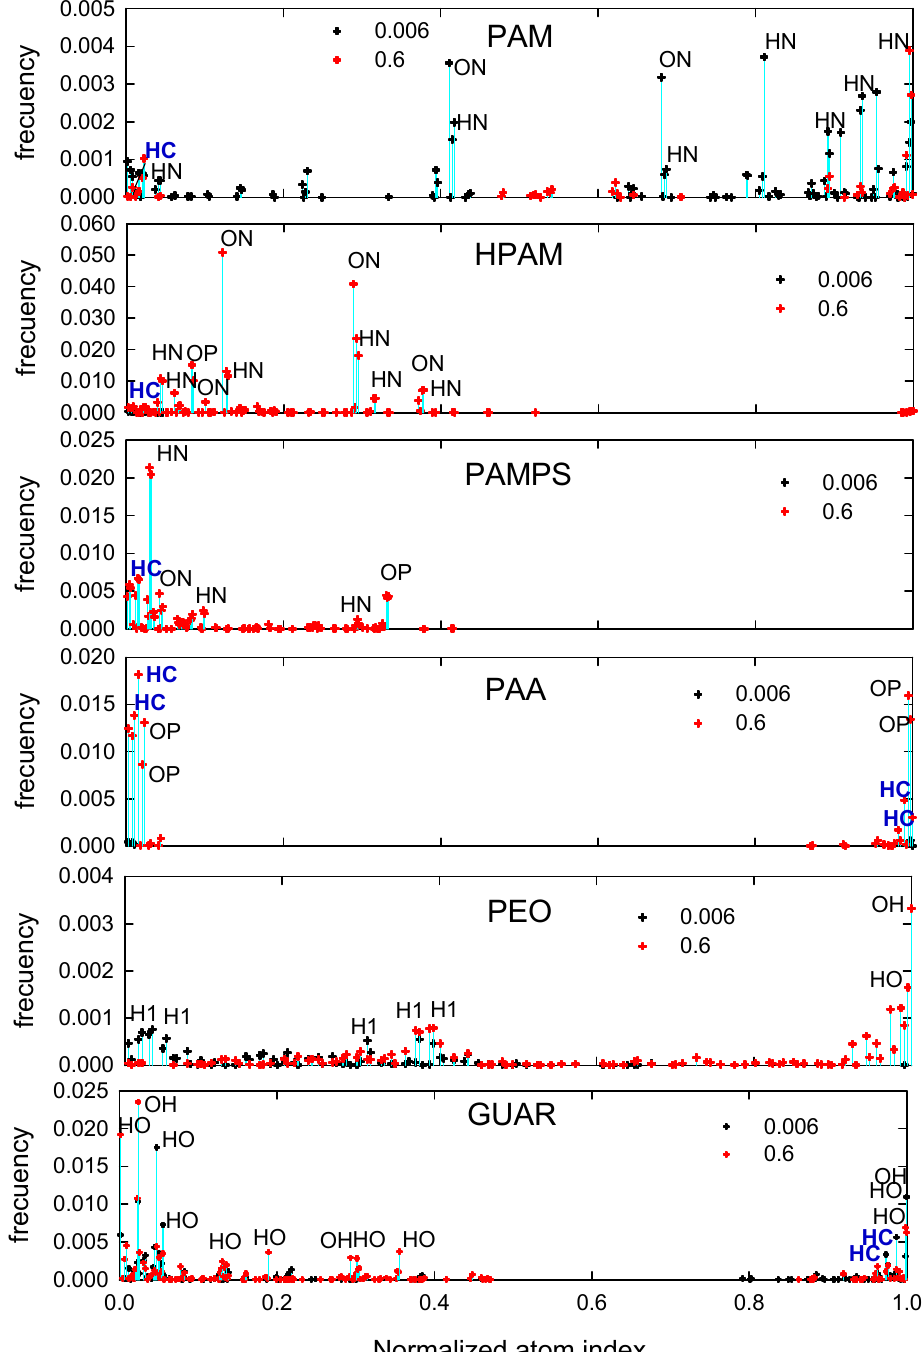
Figure 5. Distribution of interactions of the polymers with the quartz surface at different salt concentrations. HN is amine hydrogen, HC and H1 are carbon-hydrogen, OH is hydroxyl oxygen, and HO is hydroxyl hydrogen.